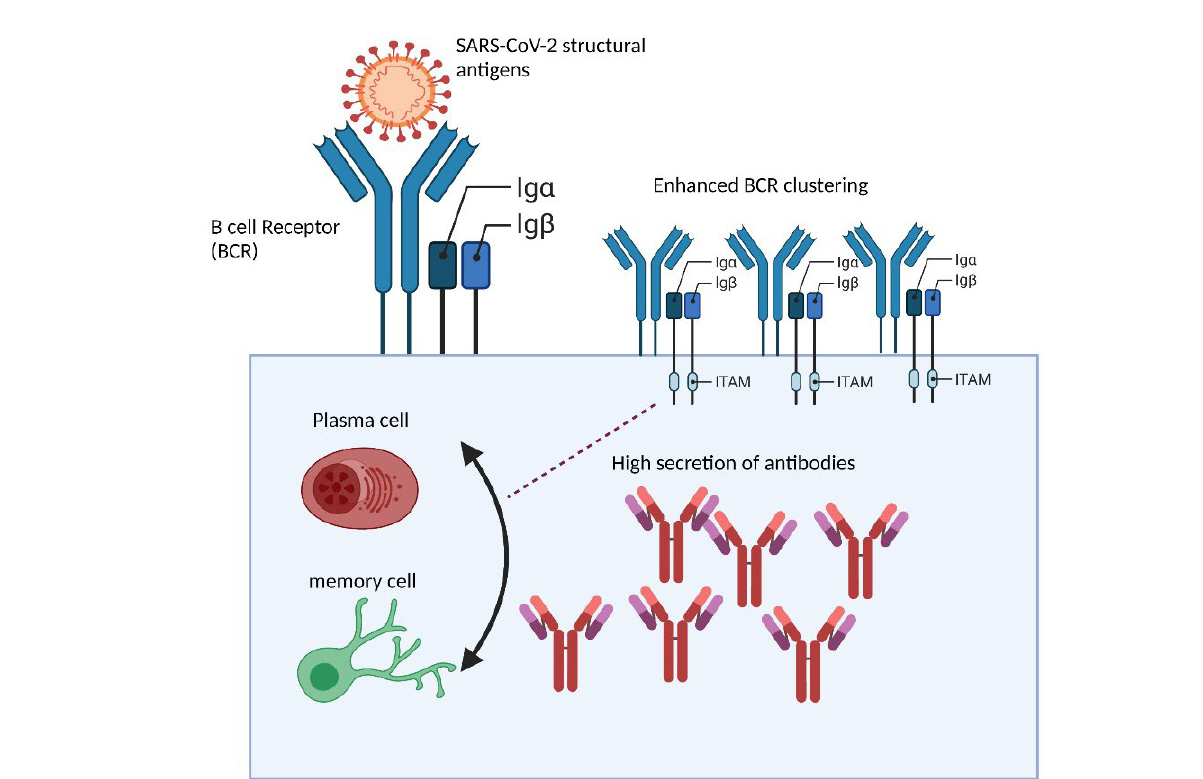
phosphorylation of ITAMs interlinked Igα, Igβ domains which are subsequently carried through underlying enzymes resulting in triggered series of humoral immune responses to combat